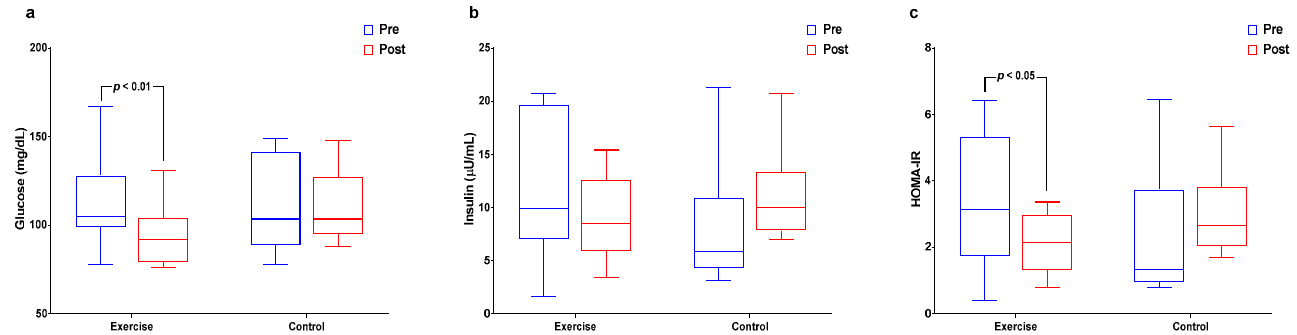
Figure 4. Effect of 12 weeks of aquatic exercise on insulin resistance in elderly Korean women. ( a ) The glucose of the exercise group decreased significantly ( p < 0.01); ( b ) Insulin showed significant interaction effects ( p < 0.05); ( c ) HOMA-IR of the exercise group was significantly decreased ( p < 0.05). HOMA-IR: homeostatic model assessment for insulin re- sistance.